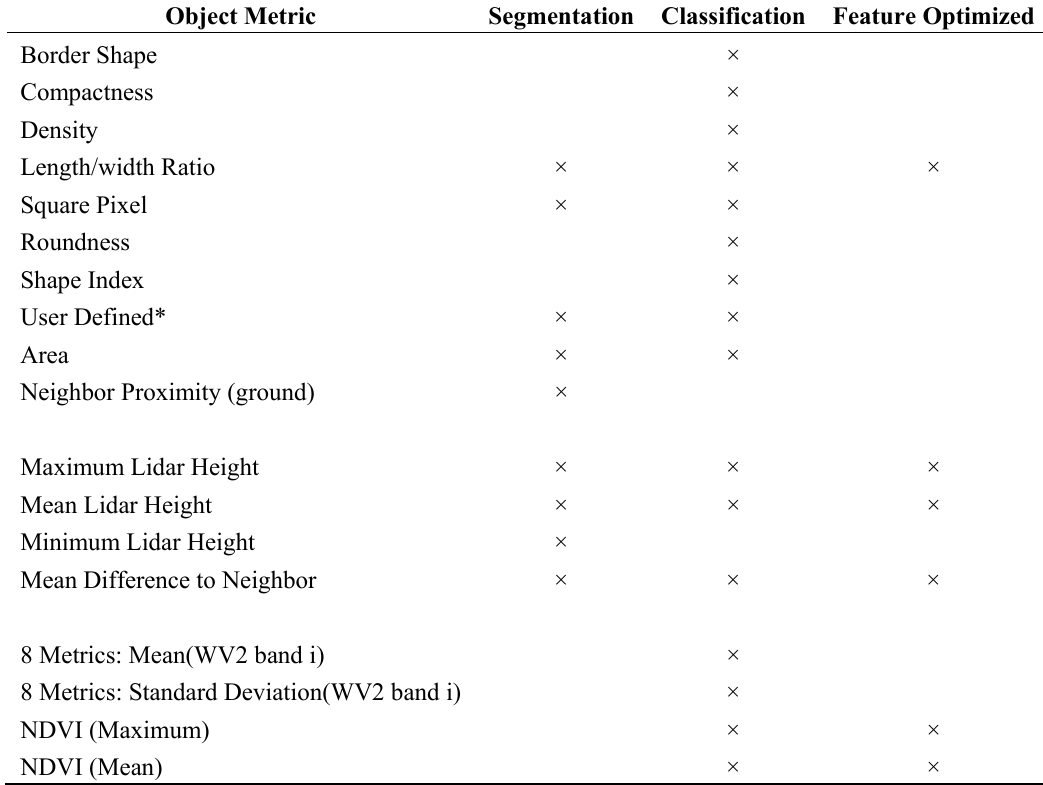
Table 2. Polygon attributes were calculated and were imported at three different stages of data processing: during the segmentation, classification of species, and feature